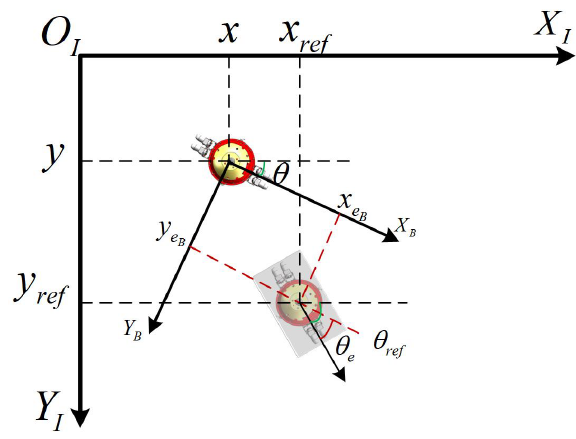
Figure 8. Definition of the pose error in the body coordinate